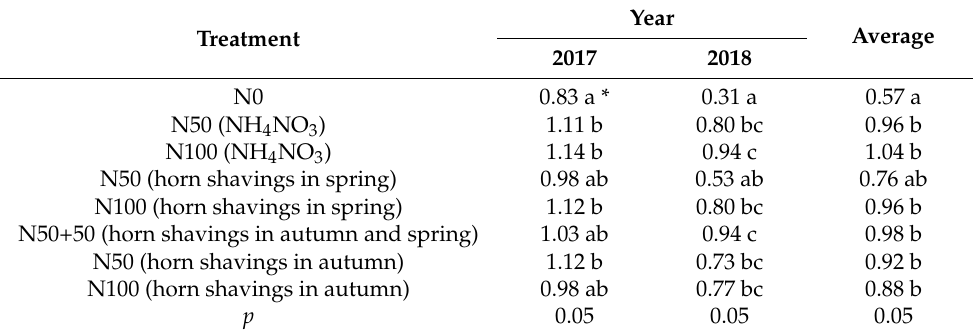
Table 9. Fertiliser effect on index of the absorption difference (IAD) of Ligol apple.